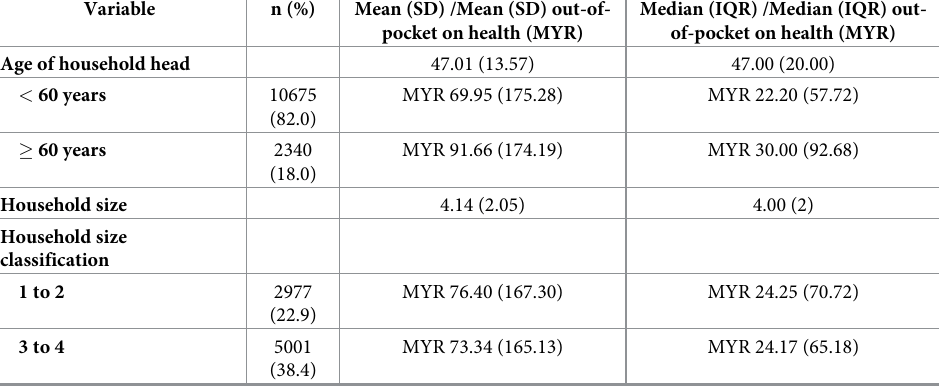
Table 1. Demographic characteristics and distribution of monthly out-of-pocket health expenditures and con- sumption (MYR) (n =